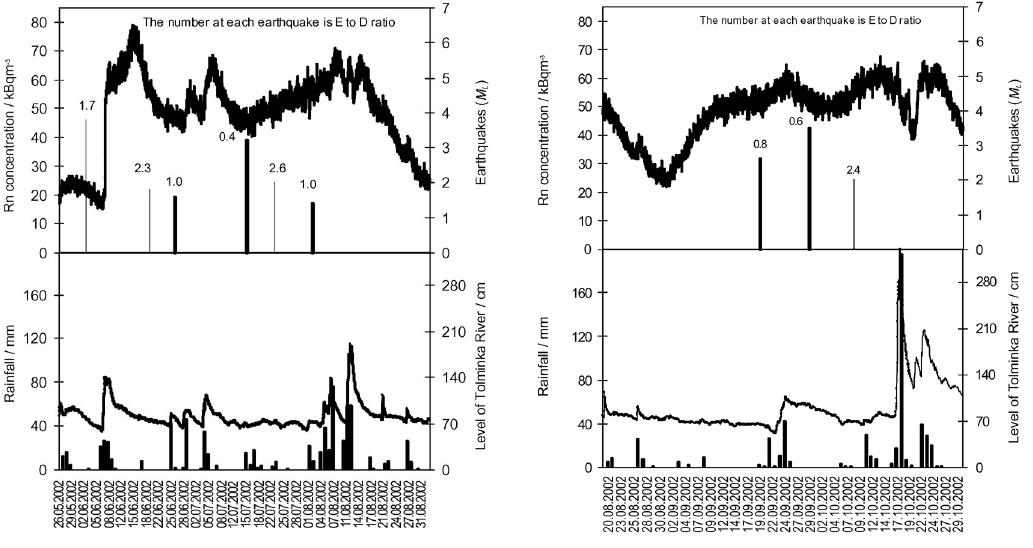
Fig. 4. Rn concentration (kBqm –3 ), earthquakes ( M L ), rainfall (mm) and the level of the Tolminka River (cm) in the thermal spring at Zatolmin between May and August 2002.